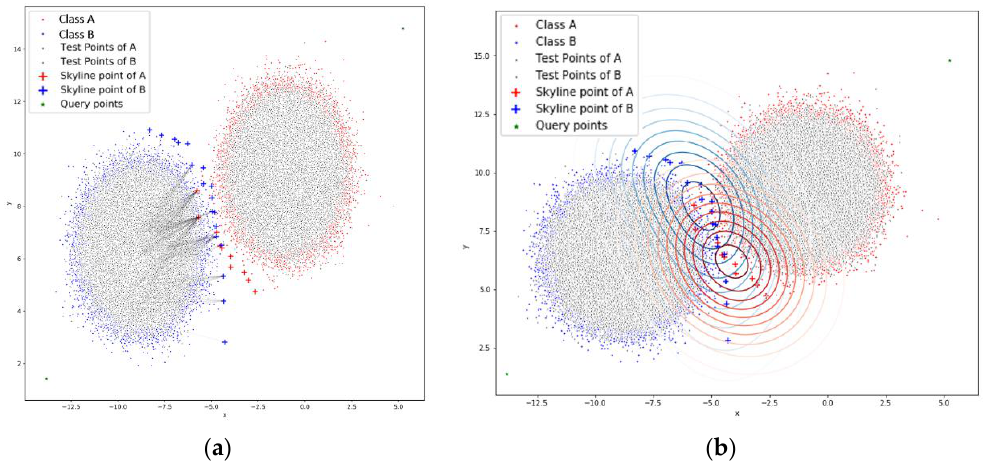
Figure 6. ( a ) SKY-nearest neighbor (SKY–NN) approach; ( b ) Parzen-window approach.